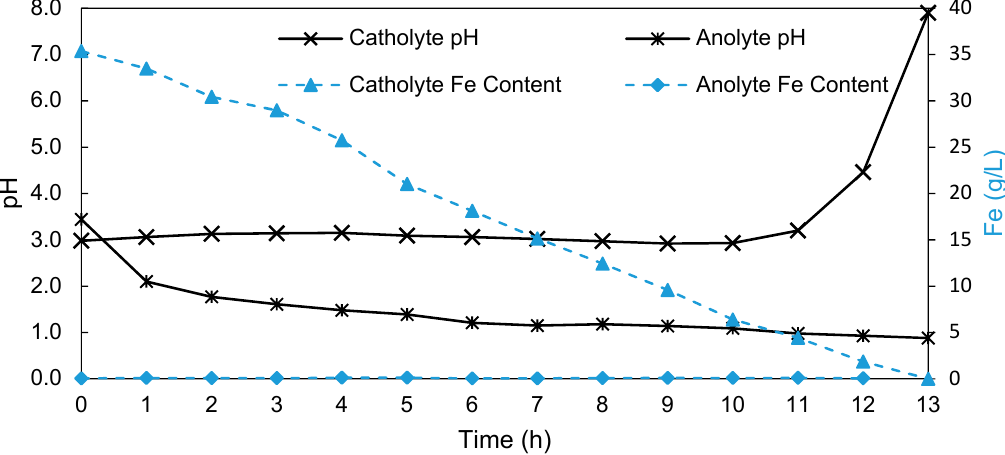
Figure 9. The pH (primary y -axis) and iron content (secondary y -axis) of both the catholyte and the anolyte over the depletion run.